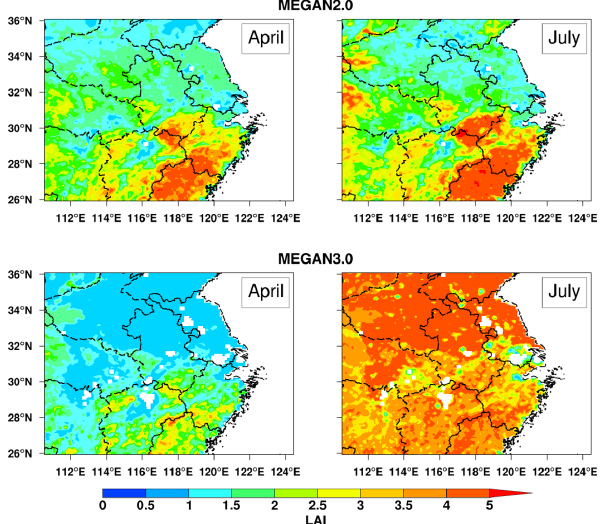
Figure 9. The spatial distribution of monthly leaf area index (LAI) from VEG-2015 in MEGAN v2.0 and MEGAN